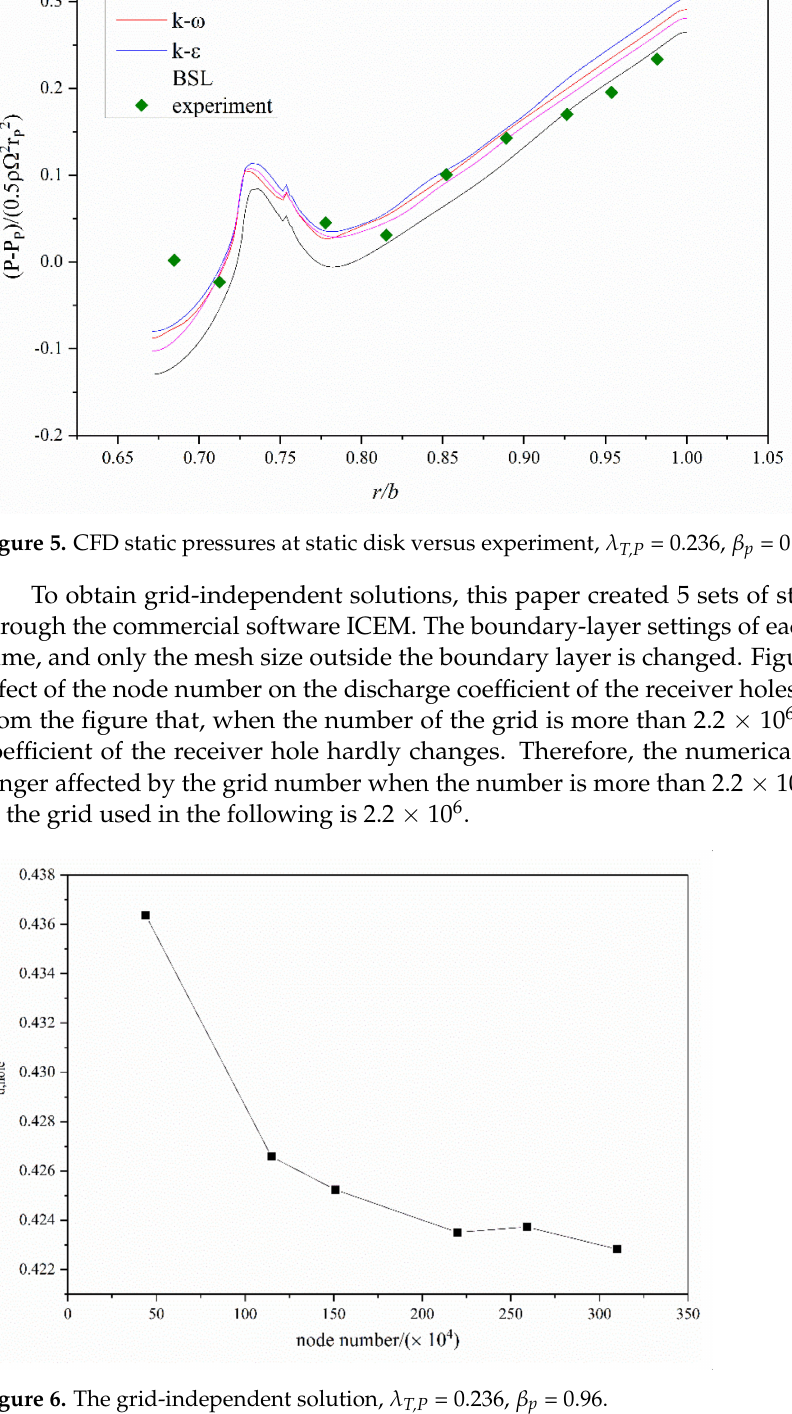
Figure 6. The grid-independent solution, λ T,P = 0.236, β p =